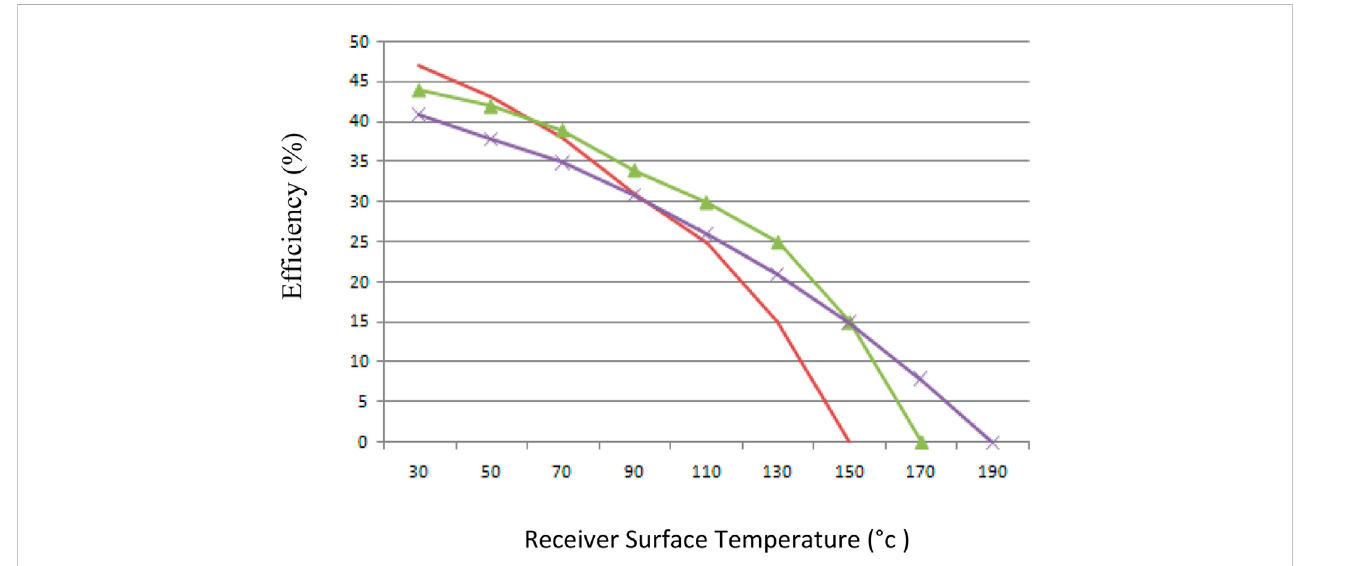
FIGURE 13 Graphical collation of receiver